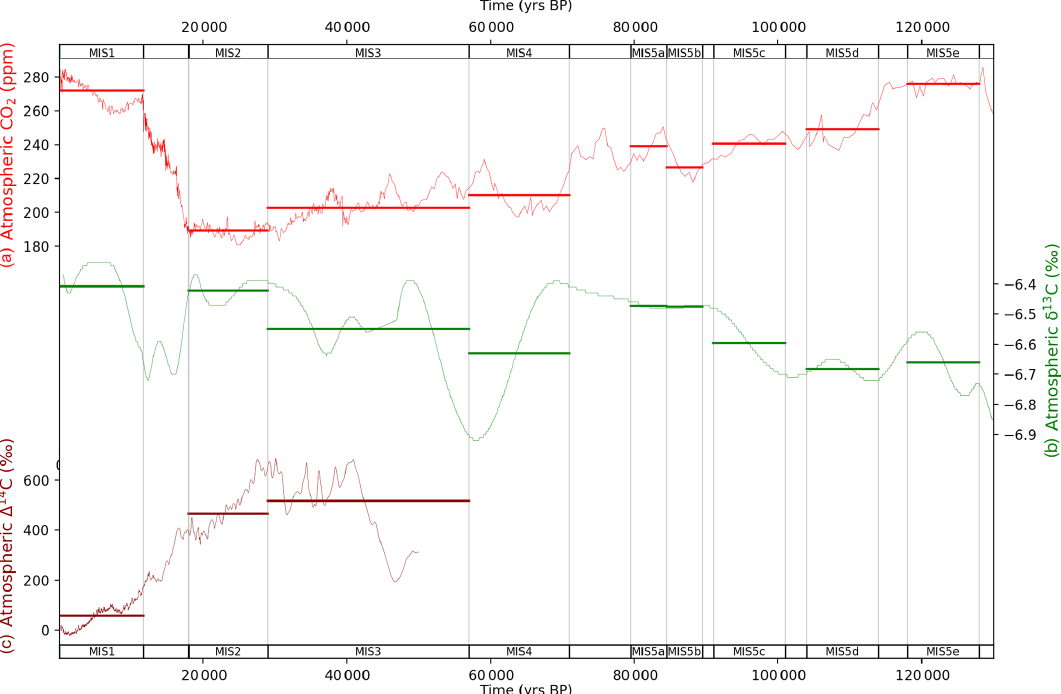
Figure 4. MIS atmosphere data for (a) atmospheric CO 2 (Monnin et al., 2004; MacFarling Meure et al., 2006; Bereiter et al., 2012; Rubino et al., 2013; Schneider et al., 2013; Ahn and Brook, 2014; Marcott et al., 2014), (b) δ 13 C (Elsig et al., 2009; Schmitt et al., 2012; Schneider et al., 2013; Eggleston et al., 2016) and (c) (cid:49) 14 C (Reimer et al., 2009). Data are shown as fine lines, with bold horizontal lines for MIS-sliced data. Natural observations for (cid:49) 14 C do not exist beyond ∼ 50ka due to the radioactive decay of 14 C. Data behind the figure are shown